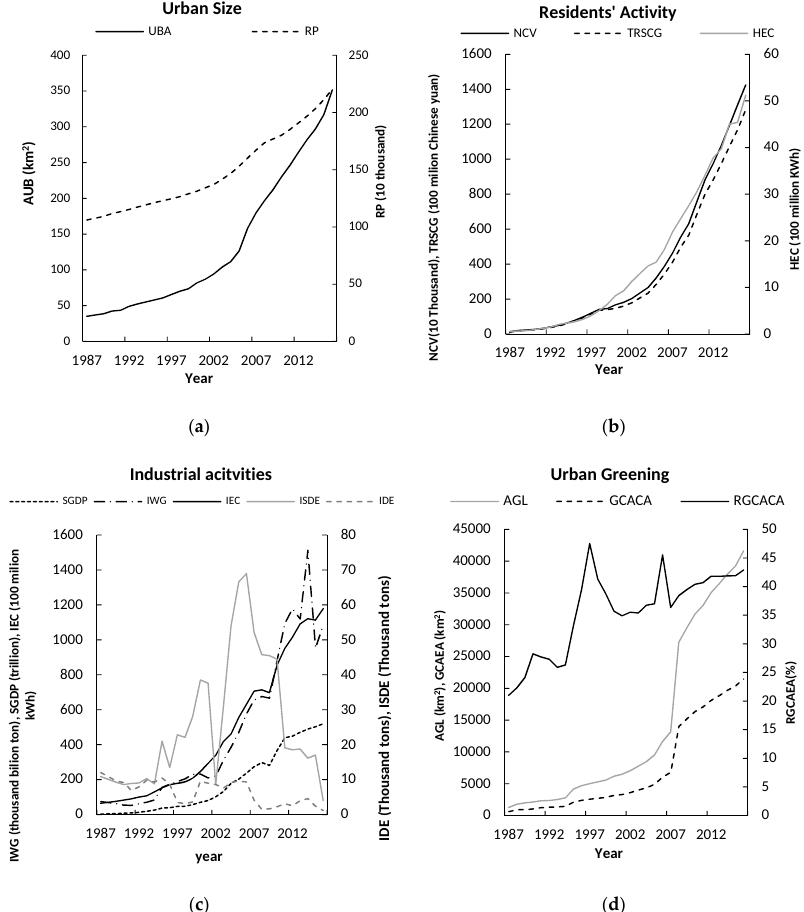
Figure 5. Variation of annual mean value of the socioeconomic factors of Xiamen, China during 1987–2016: ( a ) urban size (e.g., resident populations (RP), urban built-up areas (UBA)); ( b ) residents’ activities (e.g., total retail sales of consumer goods (TRSCG), number of civilian vehicles (NCV), household electricity consumption (HEC)); ( c ) industry activities (e.g., secondary industry gross domestic product (SGDP), industrial waste gas (IWG), Sulphur dioxide emissions (SDE), industrial dust emissions (IDE), industrial electricity consumption (IEC)); and ( d ) urban greening (e.g., green covered area of entire area (GCAEA), rate of green covered area of entire area (RGCAEA), area of green land (AGL)).